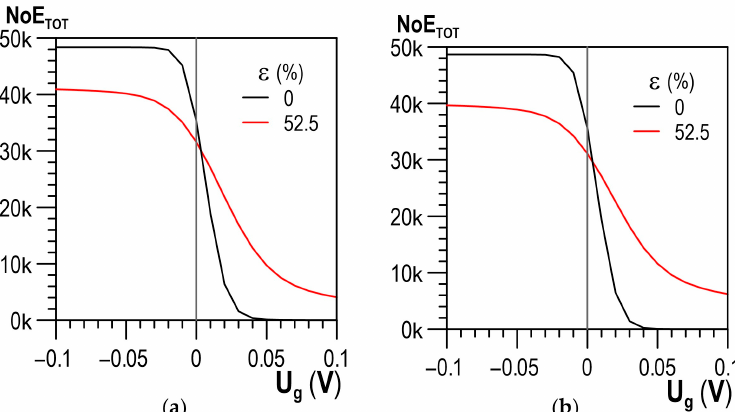
Figure 14. Distribution of the total number of events NoE TOT depending on the threshold voltage for two strain states: ( a ) parallel direction; ( b ) perpendicular direction.